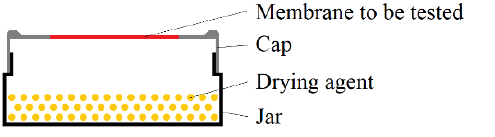
Figure 3. Sample setup for the determination of the WVTR according to DIN 53122.